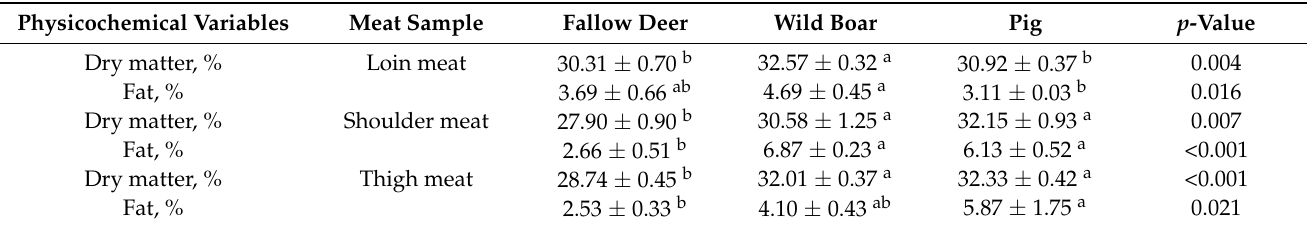
Table 1. The results of chemical measurements of loin, shoulder, and thigh muscles of meat